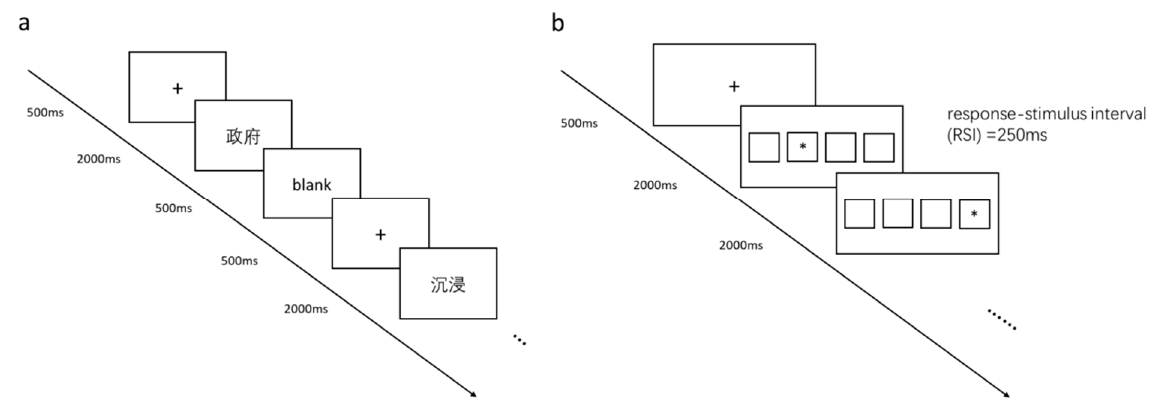
Figure 1. Behavioral task summary. Flow charts of the free recall task ( a ) and serial reaction time task ( b ).